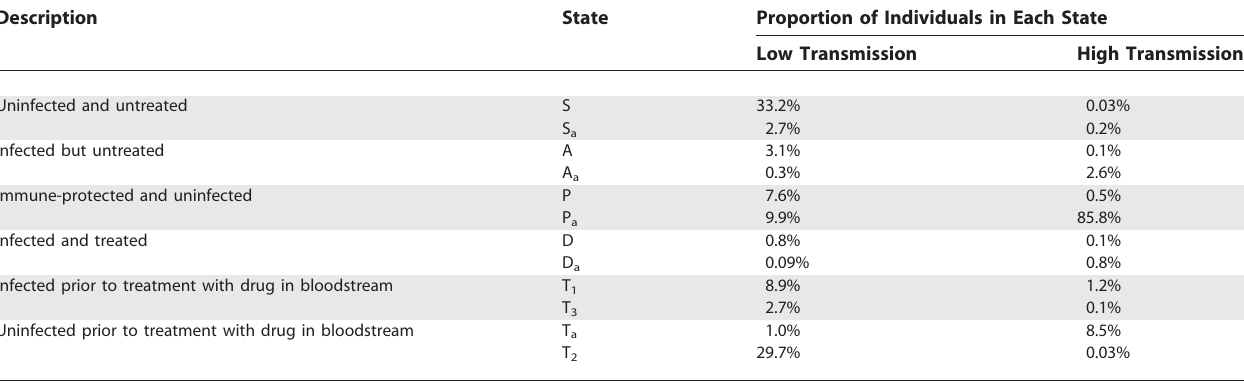
Table 1. Compartments of Human Dosing Model Categorized by Treatment, Infection, and Immune Status